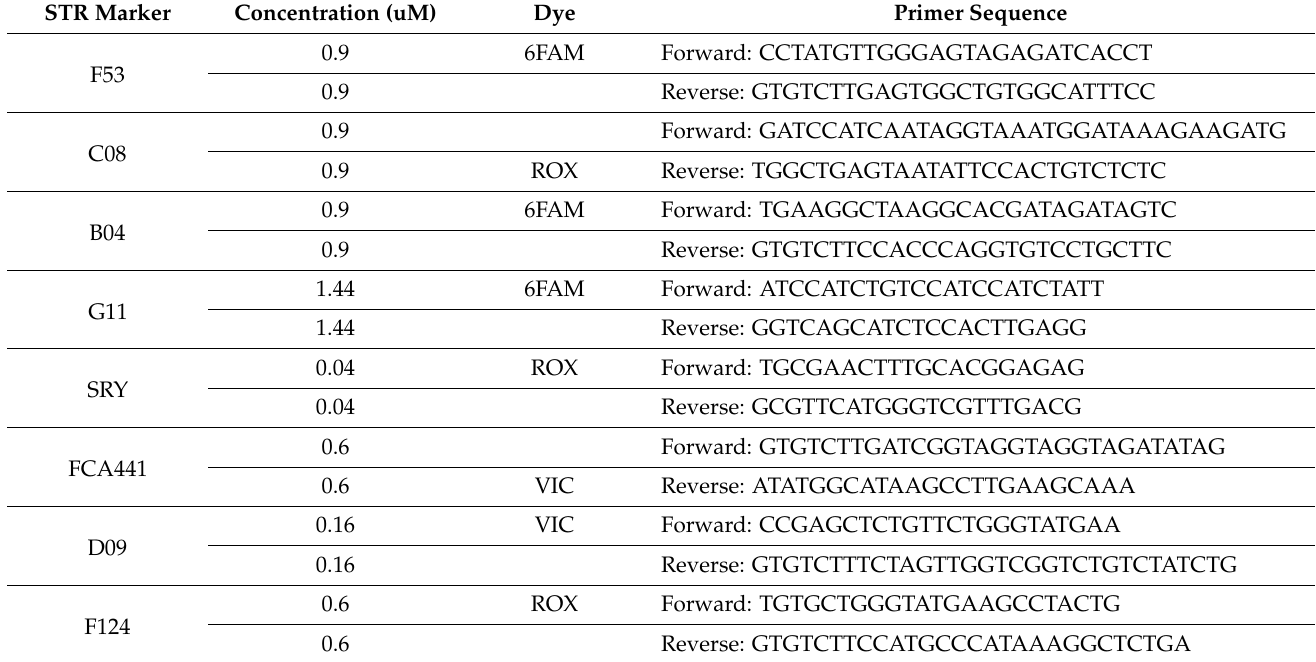
Table 2. Cat multiplex primer sequences and final